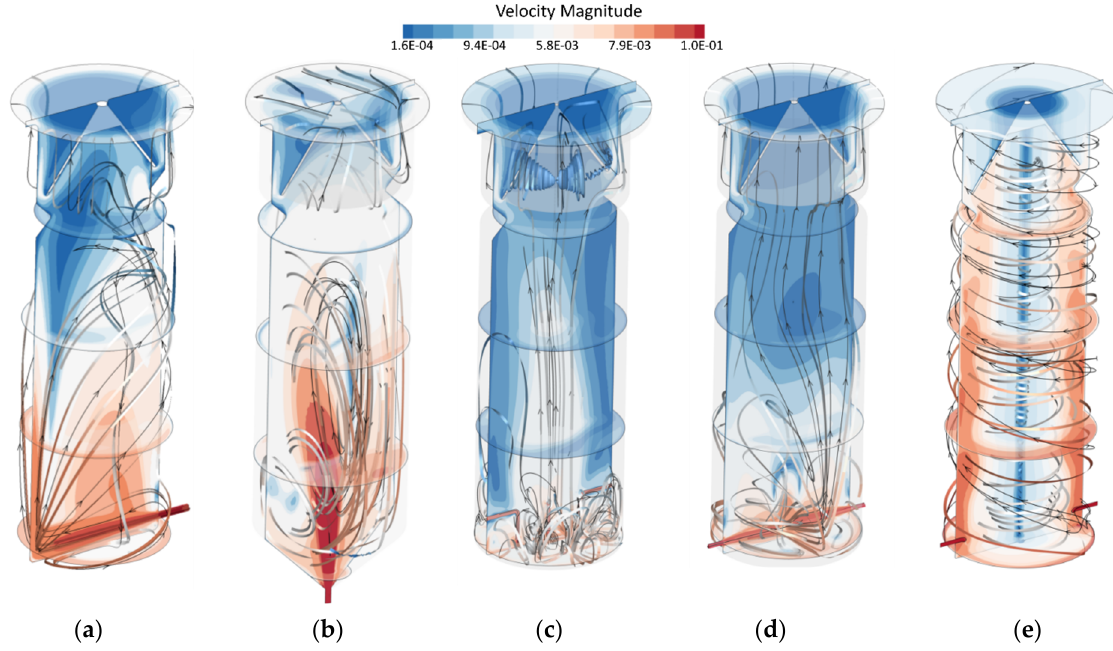
Figure 5. CFD flow path lines and velocity contours for different IDS configurations. ( a ) C1; ( b ) C2; ( c ) C3; ( d ) C4; ( e ) C5.